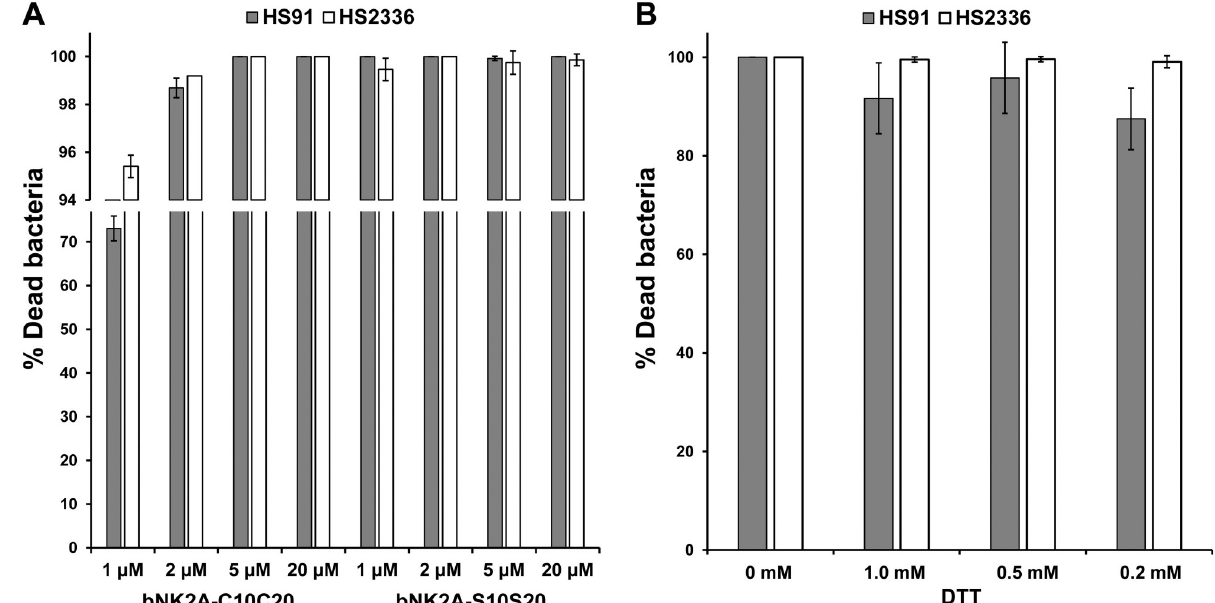
Fig 3. Both original bNK2A-C10C20 and an analog bNK2A-S10S20 peptides displayed strong antimicrobial activities against Histophilus somni . (A). Two bovine H . somni pneumonic isolates (91 and 2336) were incubated with indicated concentrations of peptides or PBS (control) and incubated at 37˚C in a humidified atmosphere of 7.5% CO 2 for 60 min. (B). The original bNK2A-C10C20 peptide (20 μ M) was pre-incubated with 0.2, 0.5, and 1.0 mM DTT for 20 min before incubation with H . somni (91 and 2336). Results shown are the means and SD of three independent experiments.